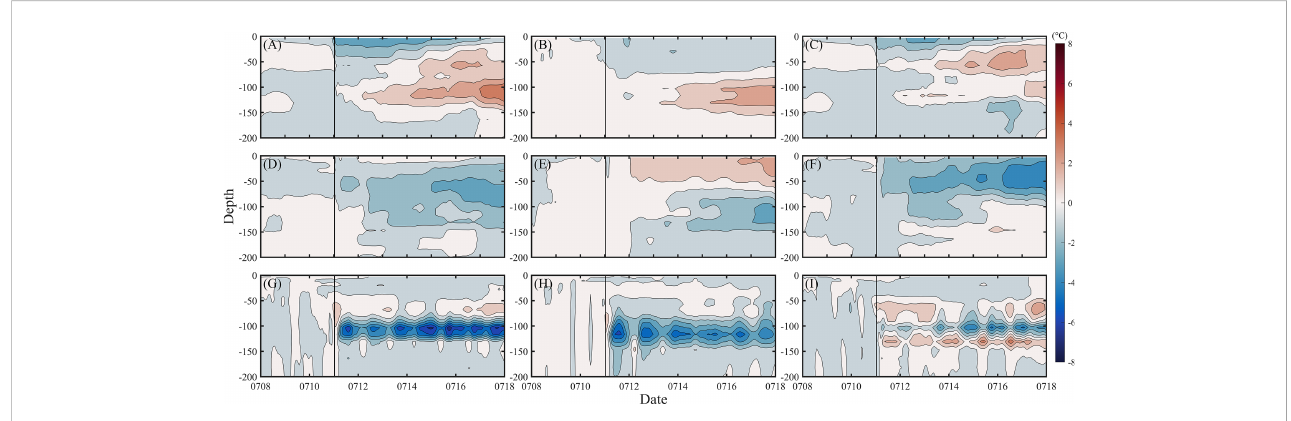
FIGURE 10 Modeled accumulated contribution of a long-track advection to the temperature anomaly in (A) EXP HYCOM , (B) EXP CLIMAT and (C) their difference; modeled accumulated contribution of cross-track advection to the temperature anomaly in (D) EXP HYCOM , (E) EXP CLIMAT and (F) their difference; modeled accumulated contribution of vertical advection to the temperature anomaly in (G) EXP HYCOM , (H) EXP CLIMAT and (I) their difference. The differences are obtained by subtracting the EXP CLIMAT values from the EXP HYCOM